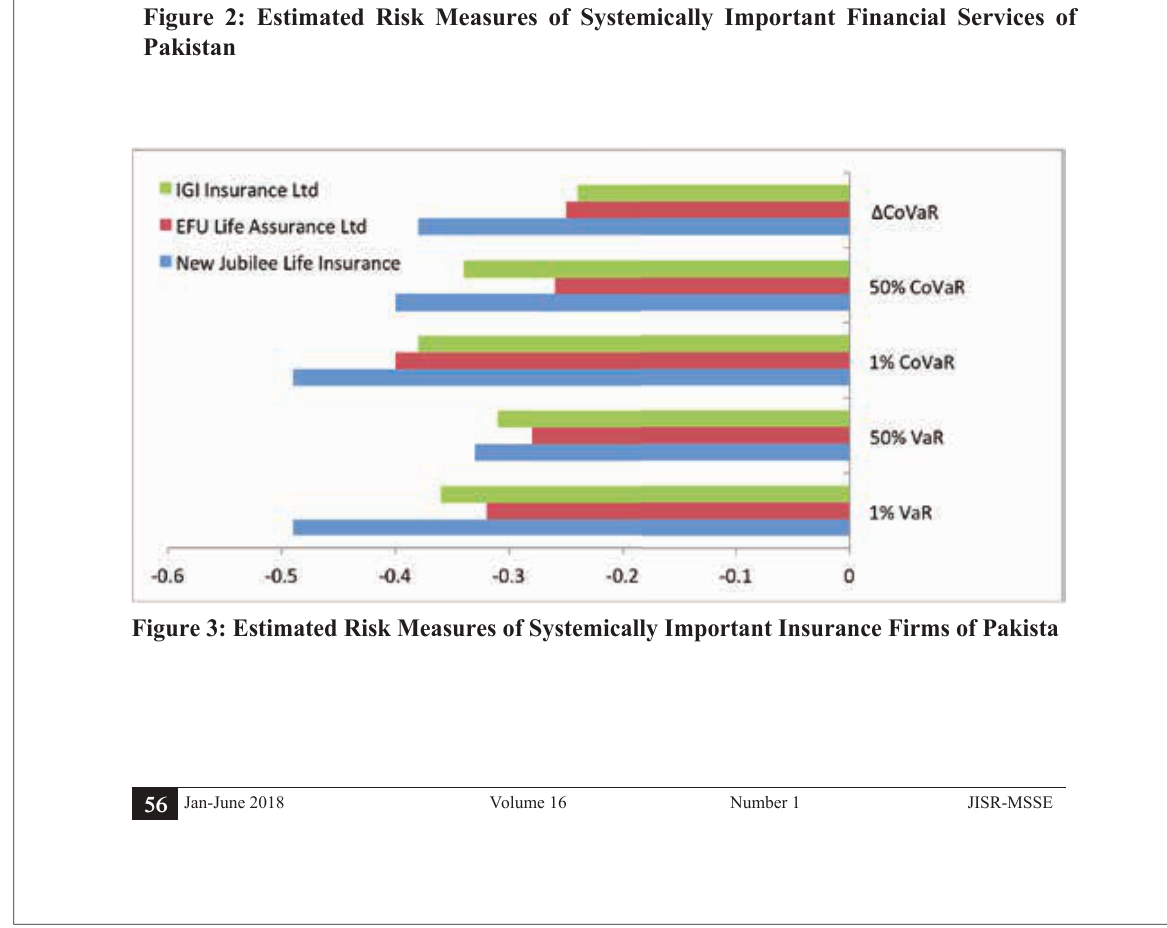
PakistaFigure 2: Estimated Risk Measures of Systemically Important Financial Services